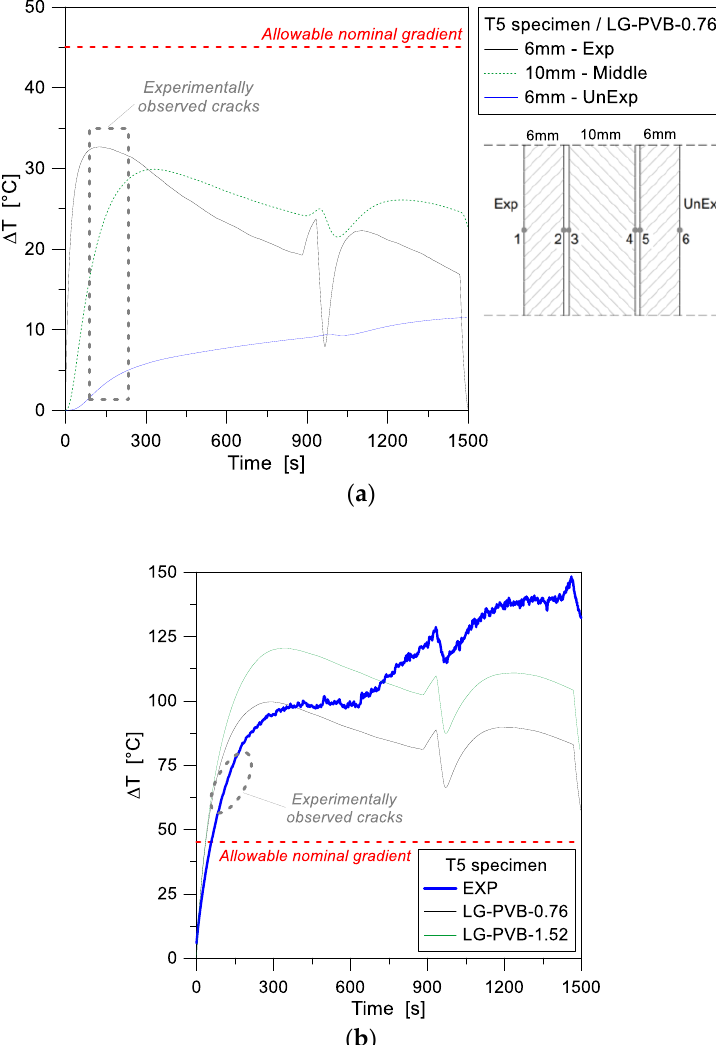
Figure 10. Temperature gradient comparisons for the LG specimen T5, as obtained from the FE parametric analyses (ABAQUS). ( a ) Numerical estimations for separate glass layers and ( b ) absolute temperature gradient for the full LG sample.